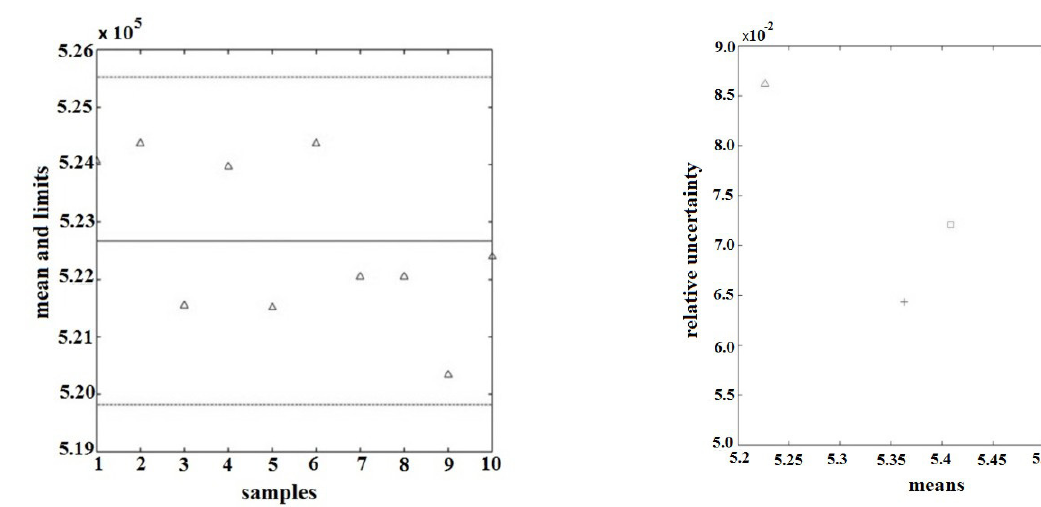
Fig. 2. Samples of the highest solid concentration around mean in a 95% interval.